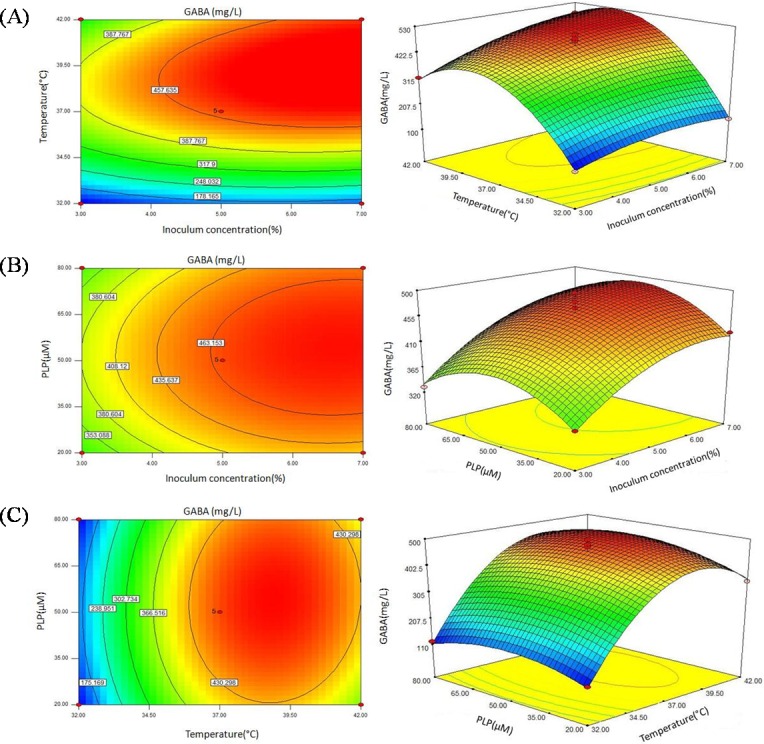
Contour plots and response surface plots showing the effect of inoculum concentration, temperature, and PLP concentration on GABA yield.